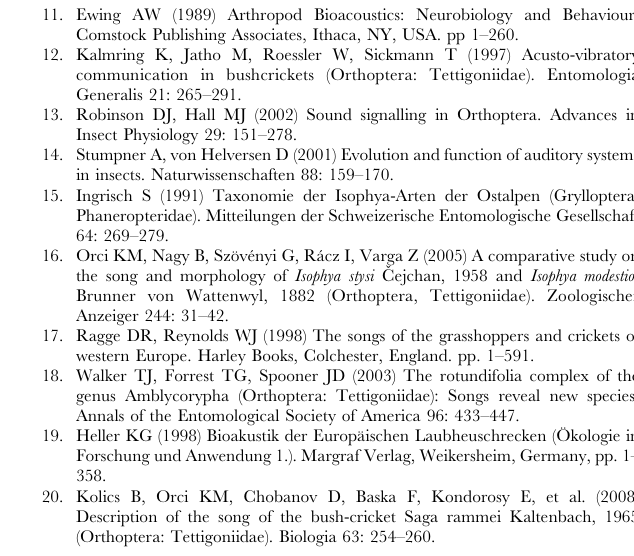
Figure S1 Comparison of the distribution territories of the parthenogenetic S. pedo and those of the bisexual relative species concerned. Figure S2 Asian Saga species have a long insertion of 115 bp in their ITS2 sequence, compared to European species. The alignment of the ITS2 insertions from three Saga species ( S. ornata, S. ephippigera, and S. cappadocica ) highlights the differences. In addition, S. ornata and S. ephippigera also have intra- specific insert variability of their ITS2 sequence. Figure S3 Bayesian majority consensus phylogenetic tree of Saginae based on three mitochondrial loci ( cytb, coxI, 16S rDNA), assuming the GTR + I + G model of sequence evolution. Vertical bars at right indicate the species. Posterior probability values are presented at each node. Banza unica was used as an outgroup. The Bayesian approach resulted ( pedo ( gracilis , campbelli )) relationship, while MP analyses showed (( pedo, gracilis ) campbelli ). Figure S4 Bayesian majority consensus phylogenetic tree of Saginae based on ITS2 gene, assuming the GTR + I + G model of sequence evolution. Vertical bars at right indicate the species. Posterior probability values are presented at each node. No outgroup was used. Samples of S. pedo and S. c. gracilis share the same ITS2 sequence, while S. c. campbelli differ from pedo-gracilis by 3 bp single nucleotide changes.